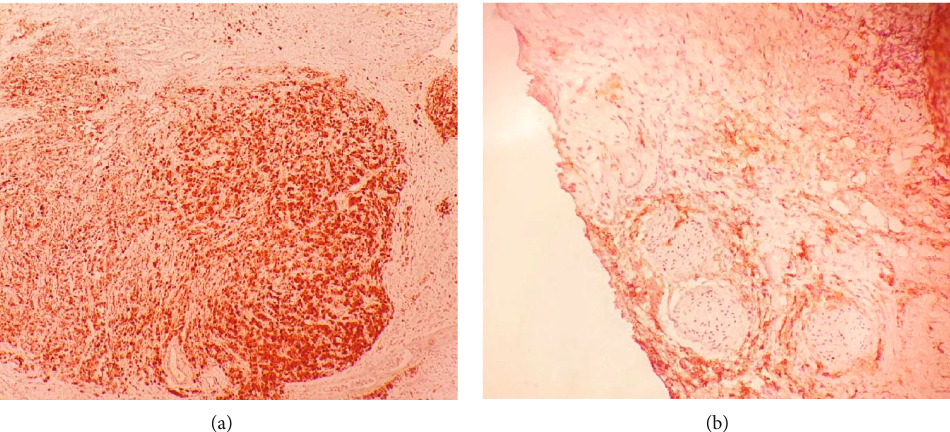
Figure 5: (a) Immunohistochemistry (G × 100): positive labeling with anti-PSA antibody. (b) Immunohistochemistry ( × 40): positive labeling with anti-PSA antibody with image of perineural neoplastic invasion.